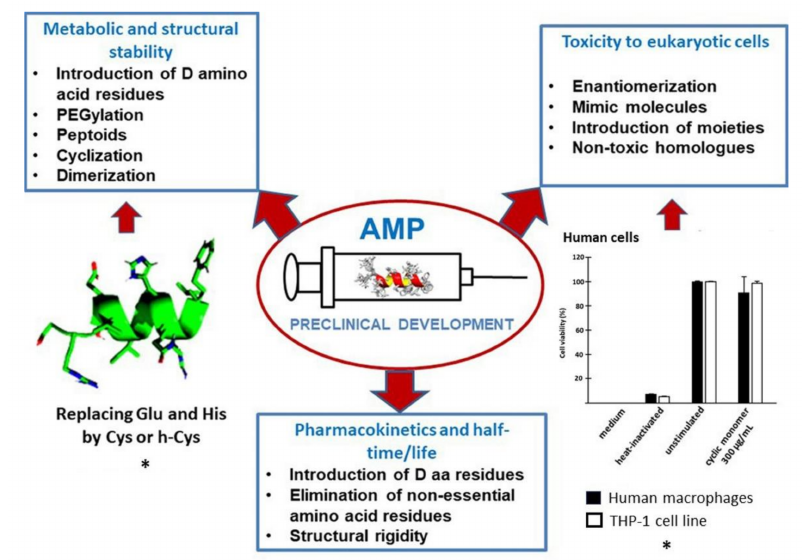
Figure 3. Some preclinical strategies for using antimicrobial peptides as therapeutic drugs. The figures marked with an asterisk were adapted from the publication ACS Omega [164]. Further permissions related to the material excerpted should be directed to the